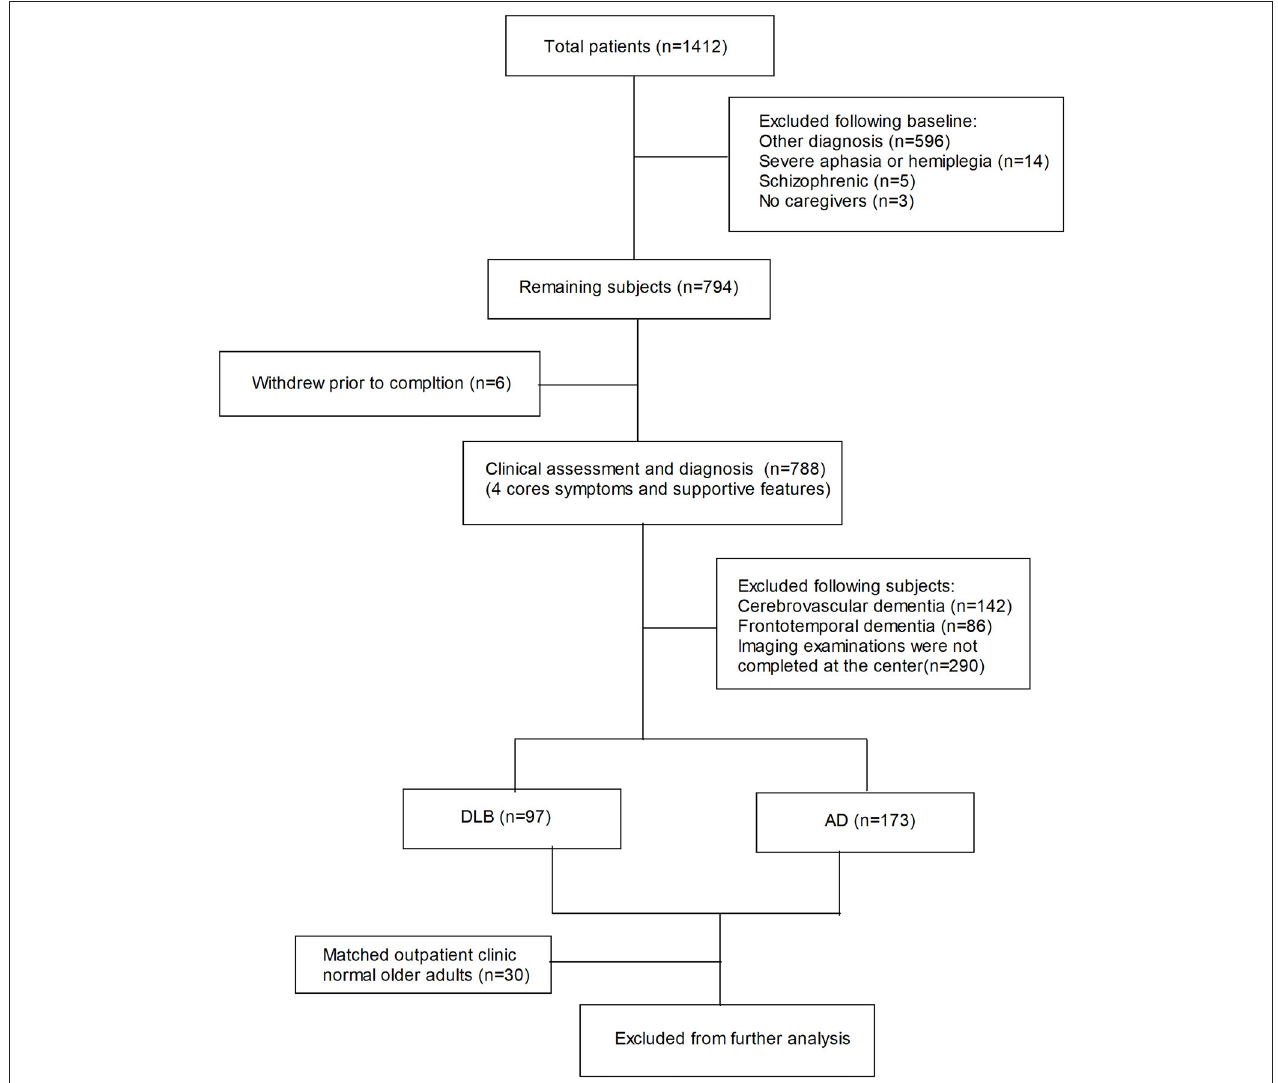
FIGURE 1 | Flow diagram. Alzheimer’s disease; DLB, dementia with Lewy